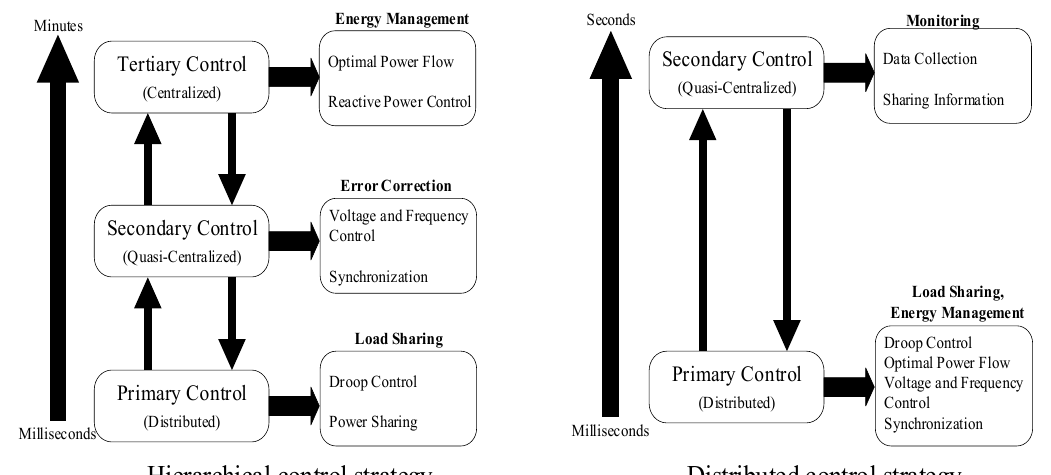
Figure 1. Microgrid control strategies